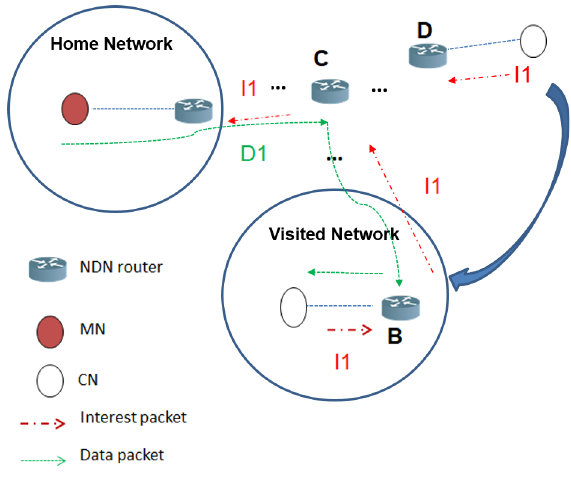
Figure 3. CN as Consumer. CN expresses interest by sending packet I1 and then moves. On the new location, CN again emits I1. Therefore, subsequent data packets reach CN at the visited